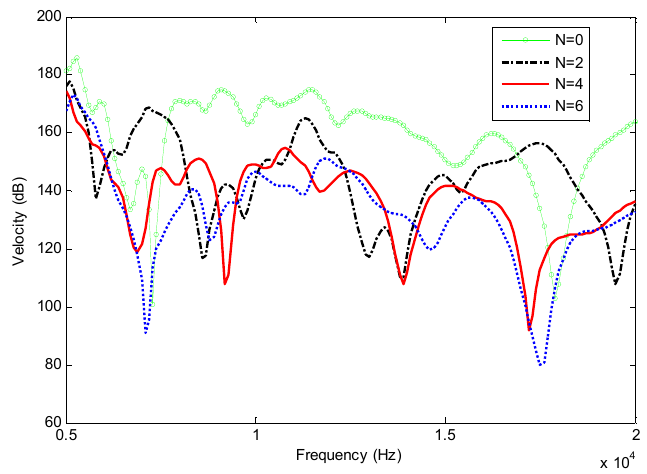
Figure 8. Frequency responses of 2D plate with different power law index.